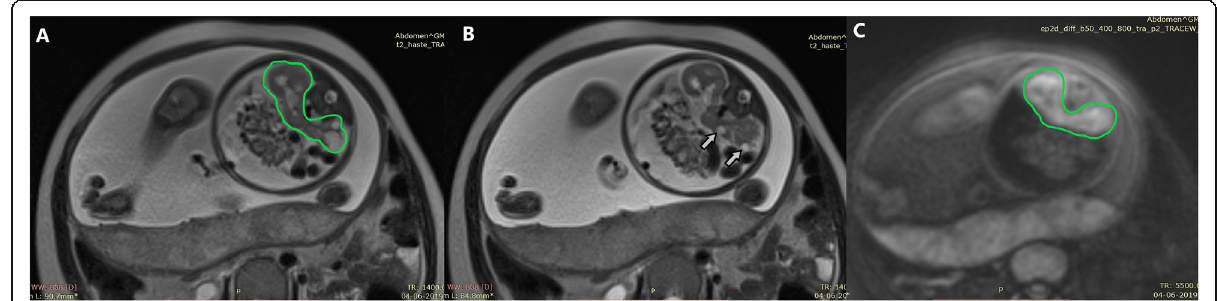
Fig. 6 The horseshoe kidney in a case of heterotaxy syndrome: maternal age: 26 years; period of gestation: 30 weeks; T2 HASTE axial ( a , b ) and DWI axial ( c ) images show typical horseshoe configuration of the fetal kidney (green tracing) with small dysplastic cysts